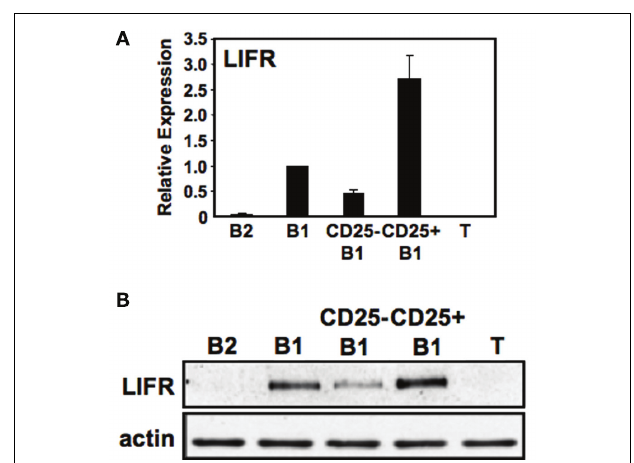
FIGURE 3 | CD25 + B1a cells display elevated levels of phosphorylated tyrosine705 STAT3. Five lymphocyte populations were sort-purified: splenic follicular B2 cells (“B2”), peritoneal B1a cells (“B1”), CD25 − peritoneal B1a cells (“CD25 − B1”), CD25 + peritoneal B1a cells (“CD25 + B1”), and splenicT cells (“T”). (A) Protein extracts were prepared from each of these populations and immunoblotted for expression of pTyr705STAT3 (“pSTAT3”). Blots were stripped and reprobed for expression of total STAT3 as a loading control. Representative results from one of two